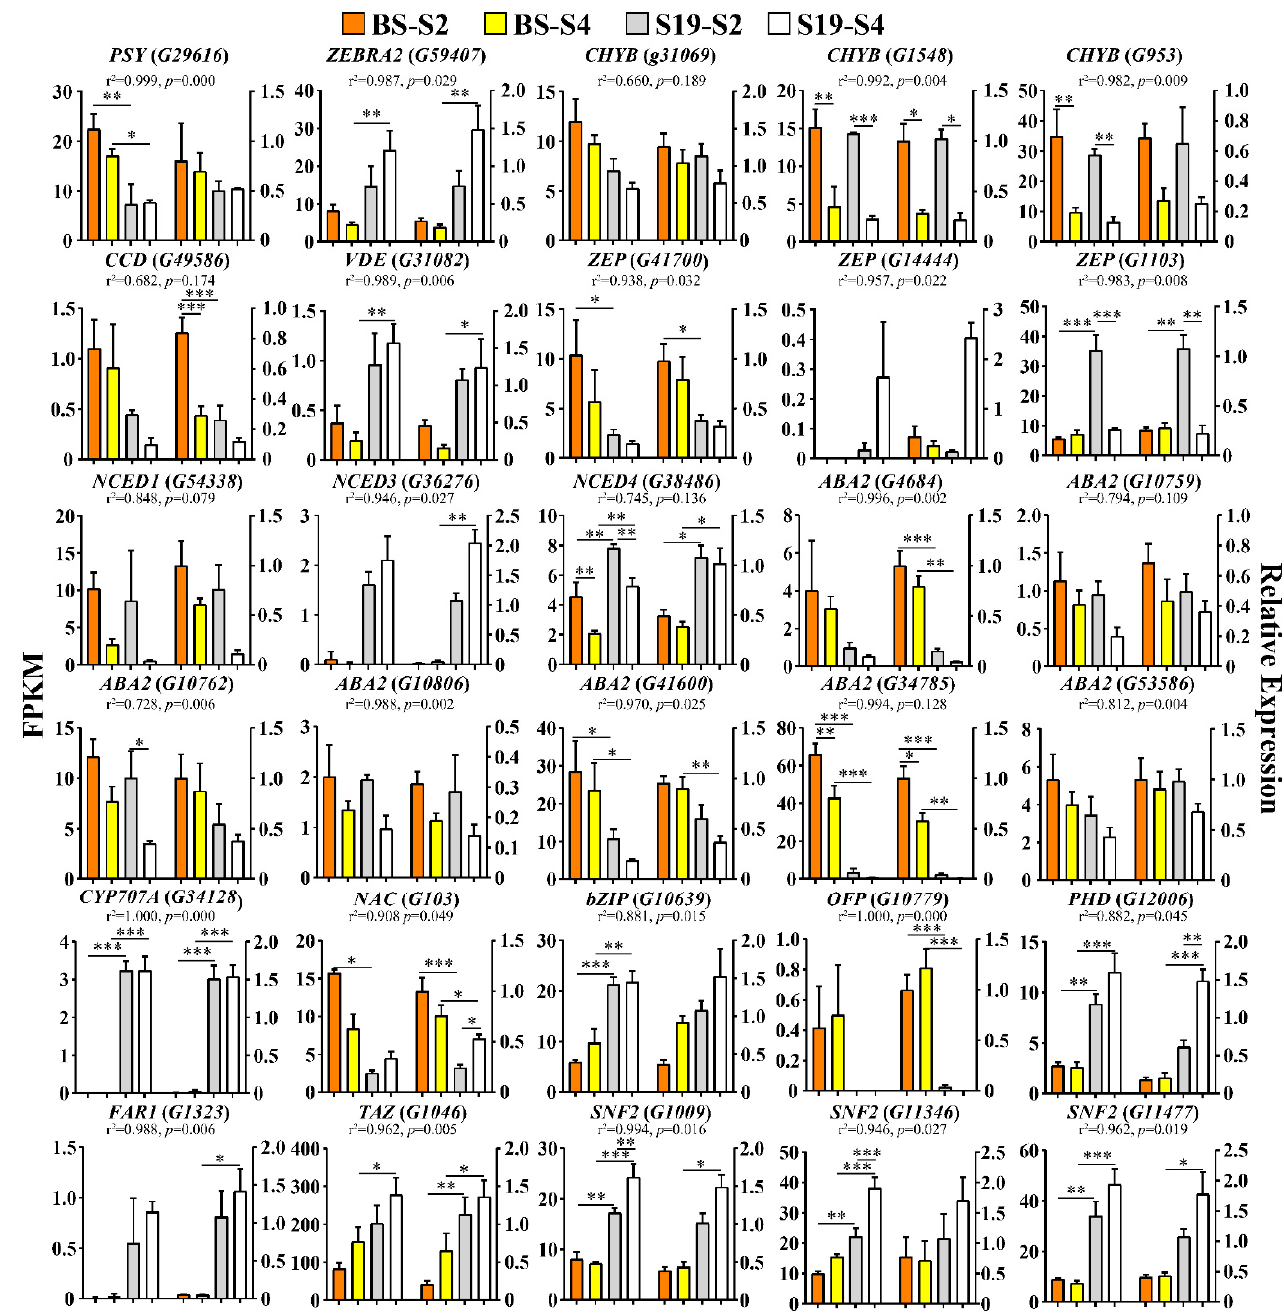
Figure 8. Expression analyses of structural genes and transcription factors associated with the carotenoid and ABA biosynthesis pathways. Data are means ± SEM ( n = 3). *** p < 0.001, ** p < 0.01, * p < 0.05.